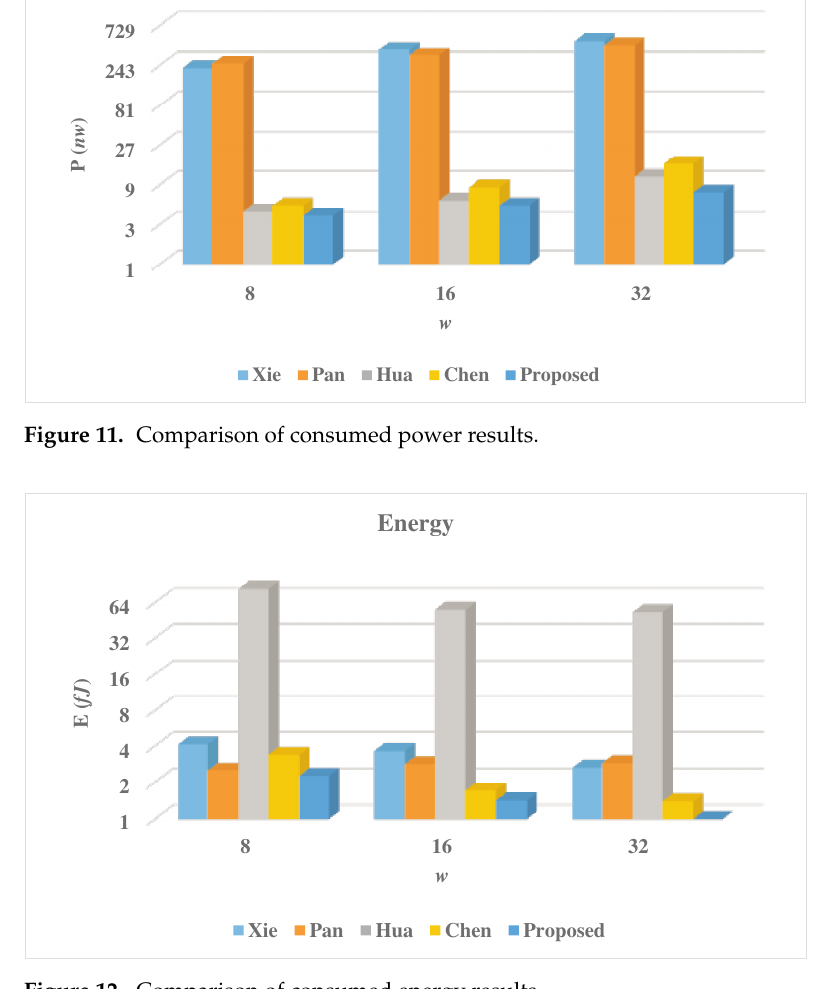
Figure 12. Comparison of consumed energy